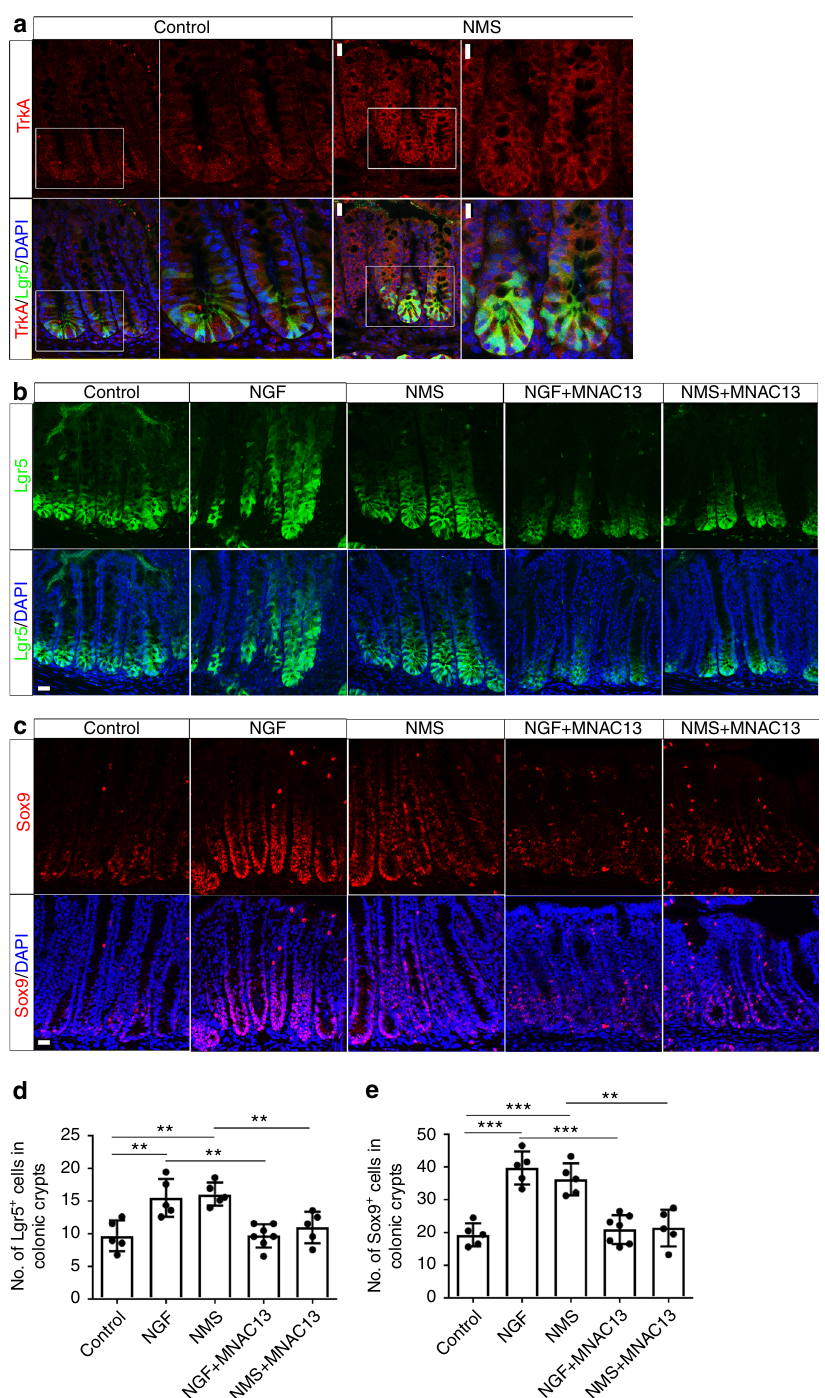
Fig. 2 NMS results in the expansion in colon stem cell compartment through NGF/TrkA signaling. a CSCs from both control ( a – d ) and NMS ( e – h ) Lgr5- EGFP + mice were labelled with EGFP (green) in the cross-sections of proximal colons. Immunostaining for TrkA (red) showed that the expression of TrkA localizes to EGFP + CSCs. c , d , g , h show the higher magni fi cation of white-boxed areas in a , b , e , f respectively. (Scale bars: 20 μ m for a, b , e, f ; 10 μ m for c , d , g , h ). b CSCs labelled with EGFP (green) in the sections of the proximal colon from both control and NMS-challenged Lgr5-EGFP + mice treated with or without intraperitoneal injection of NGF and MNAC13. The number of EGFP + cells per colonic crypts were quanti fi ed in d . ** p < 0.01, n ≥ 5/group; ANOVA (scale bars: 20 μ m). c Immunostaining for Sox9 (red) in the sections of the proximal colons from both control and NMS Lgr5-EGFP + mice treated with or without NGF and MNAC13. e shows the quanti fi cation for the average number of Sox9 + cells in colonic crypts. ** p < 0.01; *** p < 0.001, n ≥ 5/group; ANOVA (scale bars: 20 μ m). Nuclei for all panels were visualized by DAPI (blue). All data represent the mean ±